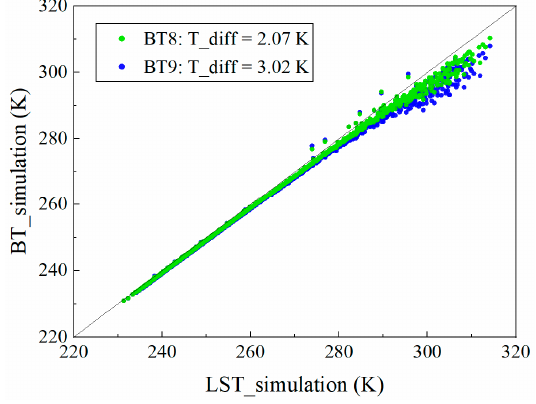
Figure 3. Relationship between simulated land surface temperature (LST) and brightness temperature (BT) of the two TIR channels. Table 1. Coefficients and root-mean-square errors (RMSEs) of different subranges for the daytime algorithm where view zenith angle (VZA) = 0 ◦